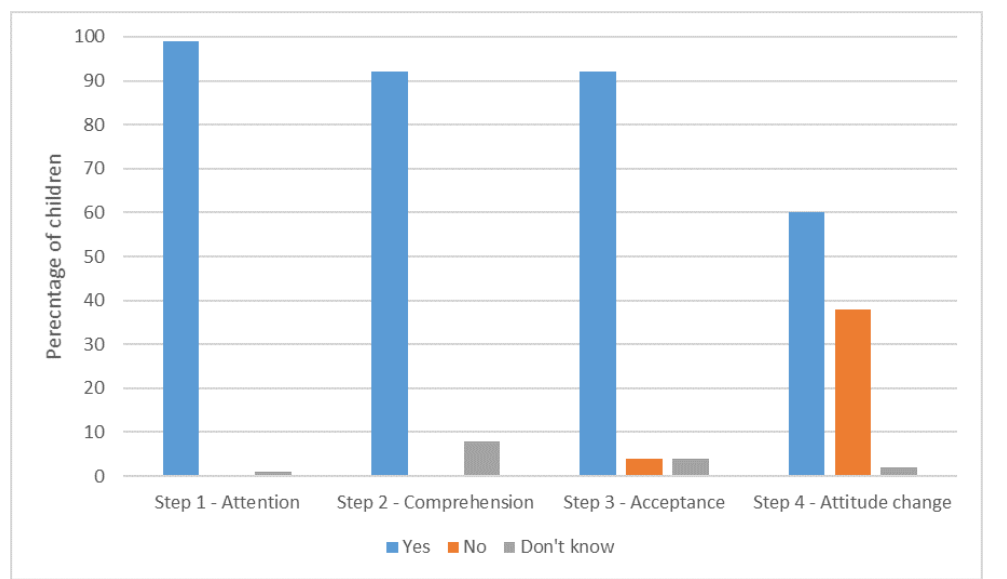
Figure 5. Design persuasiveness results.